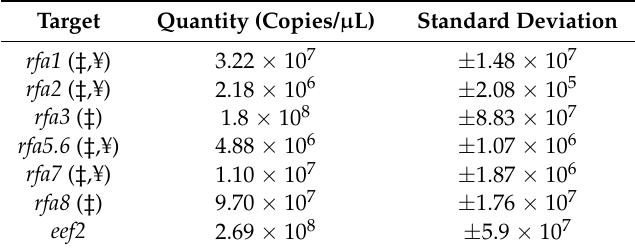
Table 4. Absolute mRNA levels of RPA genes.